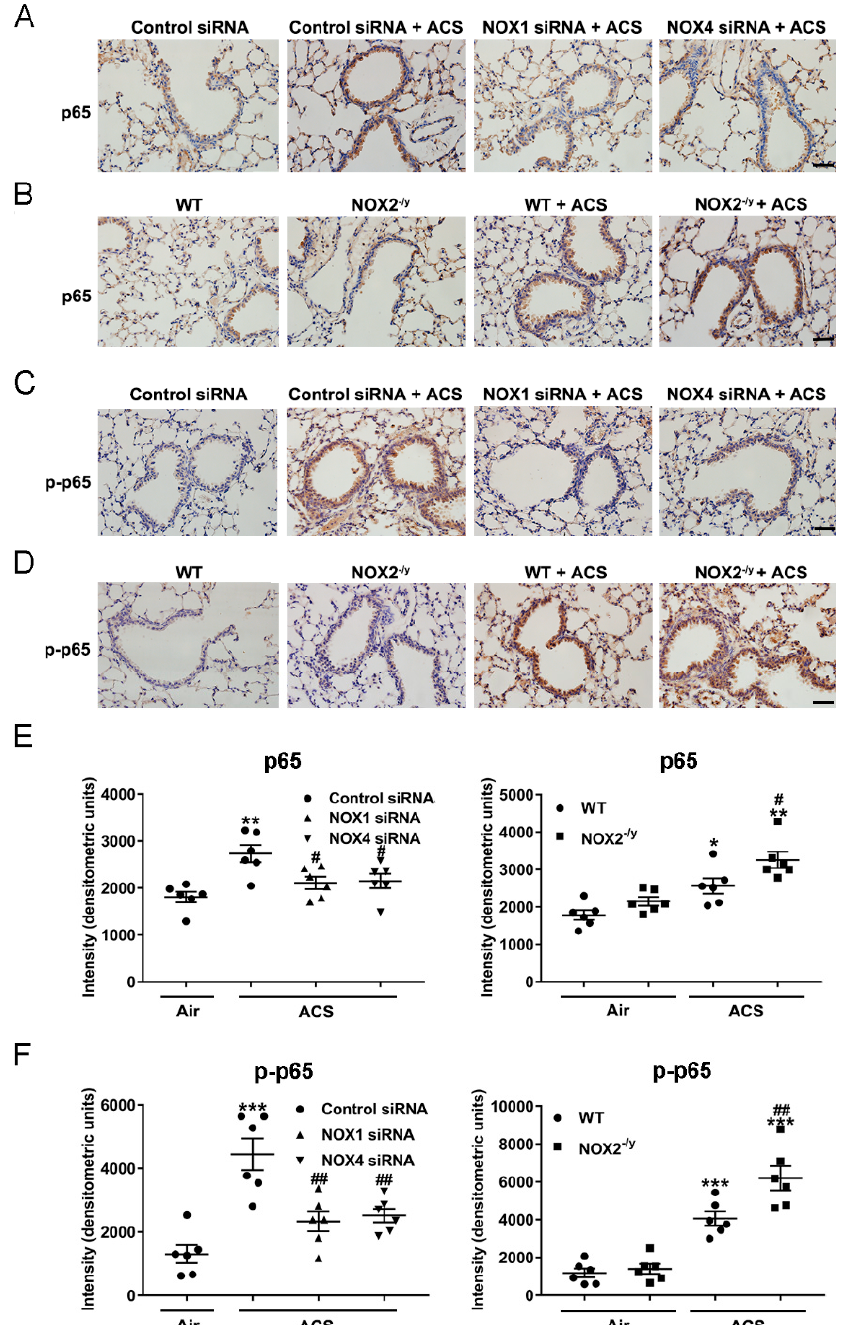
Figure 7. Knockdown of NOX1 or NOX4 attenuated ACS induced NF- κ B activation in the mouse lung . Mice were exposed to CS or filtered air for 1 h and harvested at 6 h. Shown are representative immunohistochemical images of p65 ( A , B ) and p-p65 ( C , D ) expression in ACS exposed mice silenced or knocked out of NOX1, NOX2, or NOX4. Quantitative data of p65 and p-p65 expression in ACS exposed mice silenced or knocked out of NOX1, NOX2, or NOX4 are shown in panels ( E , F ), respectively. The data indicate that ACS induced activation of NF- κ B was significantly attenuated in NOX1- or NOX4-silenced mice, while it was increased in NOX2 − /y mice. All data are presented as Mean ± SEM, n = 6. Scale bar, 50 µ m. * p < 0.05, ** p < 0.01, *** p < 0.001 vs. air exposed control group. # p < 0.05, ## p < 0.01 vs. ACS exposed group.